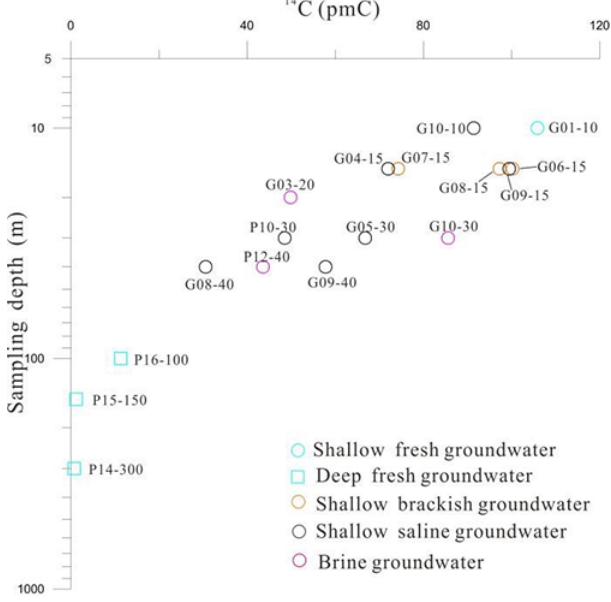
Figure 5. 14 C activity with sampling depth in